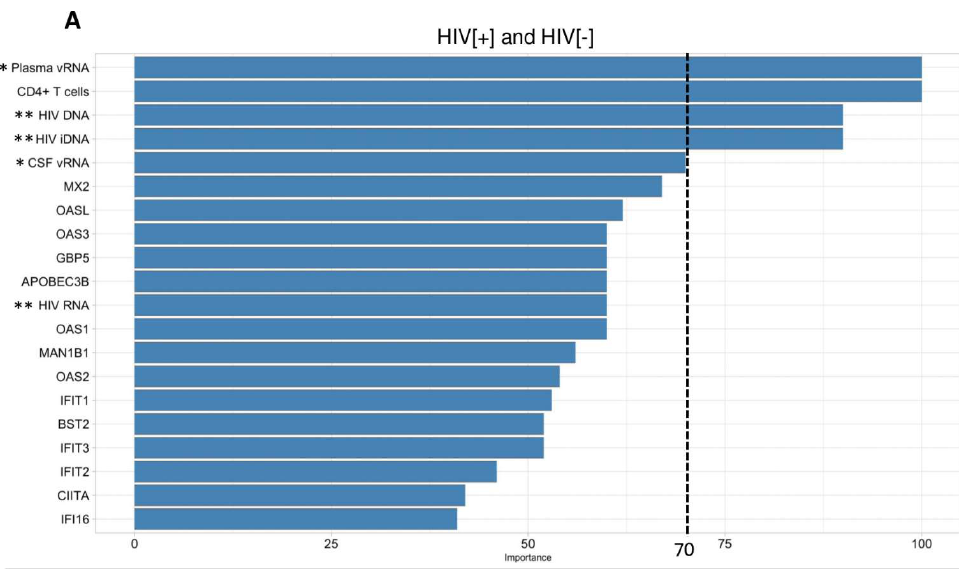
Figure 7. Analyses of variables predicting clinical group classification by machine learning . The regularized logistic regression machine learning method was used to predict variables that distin- guished the HIV[+] group from the HIV[−] group ( A ). Shrinkage discriminant analysis predicted the variable importance for the HIV[+] and HIV[+]/HAND group classification ( B ). An importance value of 70 was set as a threshold. An importance value between 70 and 100 indicates a heavy reli- ance of machine learning prediction on a specific variable in classifying and distinguishing the